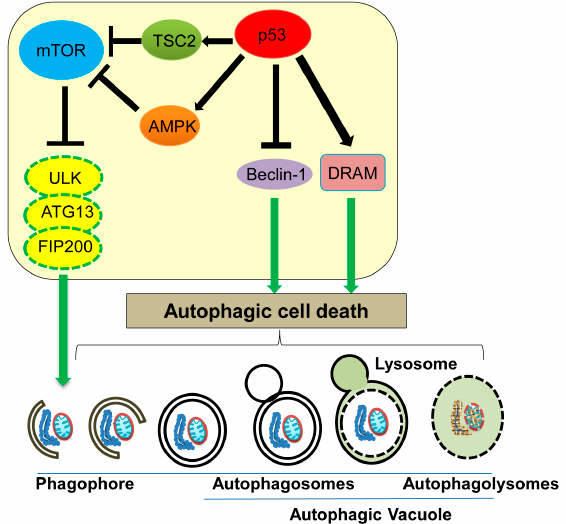
Figure 4. Autophagic cell death and its regulation by p53. Nuclear p53 induces autophagic cell death by transcriptionally upregulating tuberous sclerosis (TSC2), AMP-activated protein kinase (AMPK), and damage-regulated autophagy modulator (DRAM), whereas cytoplasmic p53 inhibits autophagic cell death by inducing Beclin-1 degradation. mTOR: mammalian target of rapamycin.